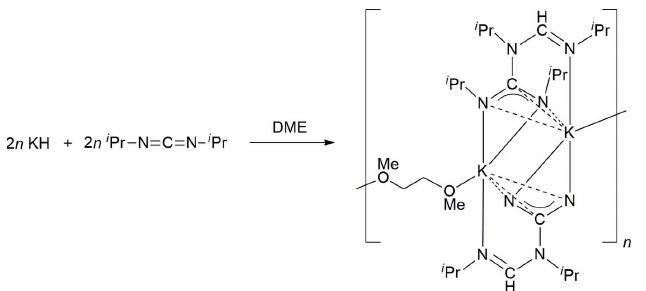
Figure 1 Formation of the title compound by reaction of potassium hydride with N , N 0 -diisopropylcarbodiimide in